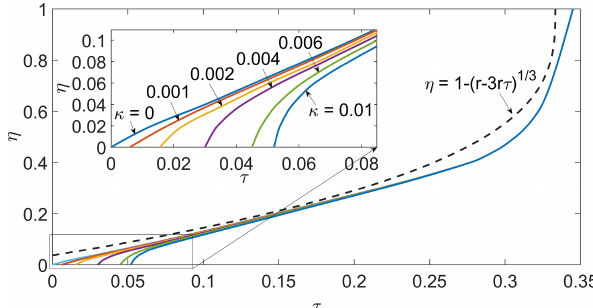
Figure 9. The location of the saddle-node bifurcation point in Fig. 6 (if it exists) or the location where the boundary reaches d t = 1 when there is no saddle-node bifurcation, plotted as τ at the bifurcation point against the corresponding η , for different values of scaled frac- ture toughness, κ . An enlargement of the bottom left-hand corner identifying the colour scheme is shown at top left. The dashed curve represents the analytical calving law in Eq.